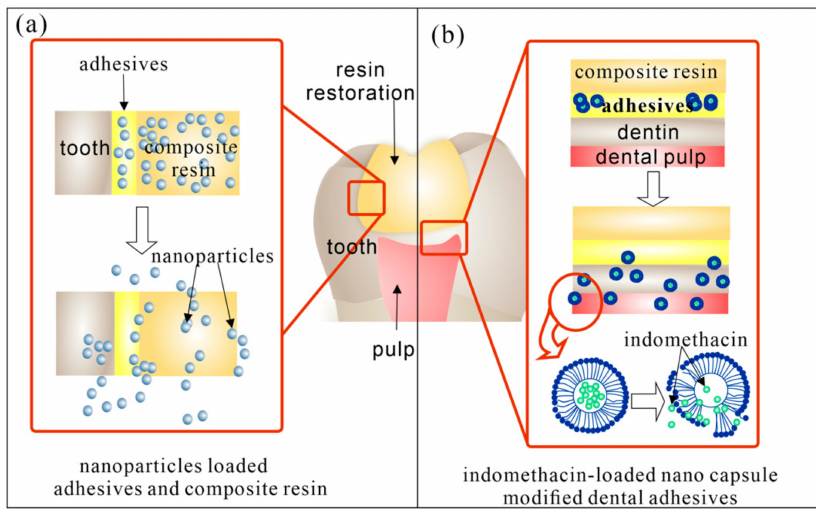
Figure 4. Recent DDS for secondary caries. ( a ) Nanoparticles loaded restoration resin. Adhesives and composite resin could be loaded with anti-bacterial nanoparticle (such as Ag and ZnO) and remineralizating agents like Nano-ACP. ( b ) Indonmethacin-loaded lipid-based nano capsules modified dental adhesives. The nano capsules could release from the adhesives with sustained release of indomethacin which had anti-inflammatory e ff ect on dental